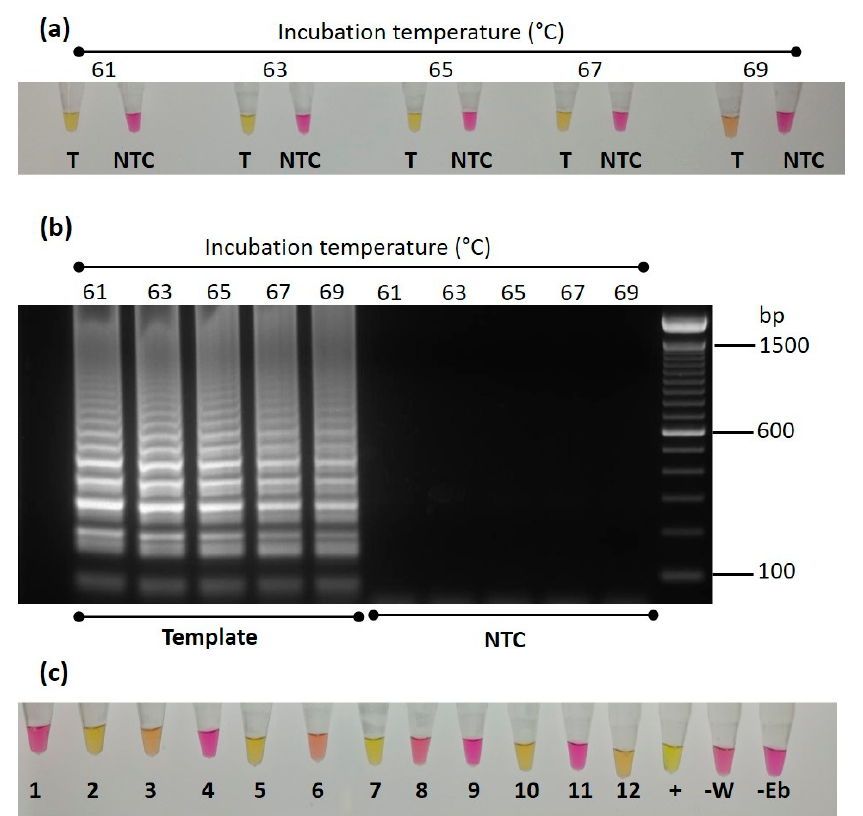
Figure 5. Optimization and testing of colorimetric Loop-mediated isothermal amplification (LAMP) for detection of cacao yellow vein-banding virus (CYVBV). ( a ) LAMP reaction containing 50 ng of DNA of symptomatic ICS 27 sample (T) or without DNA (NTC) were incubated at 61, 63, 65, 67 and 69 °C. After 30 min, samples were removed from the thermal cycler and cooled on ice to stop the reaction. Photograph shows the pink to yellow colour change in the reaction with template DNA. ( b ) The RT-LAMP reaction products were analysed on a 2% agarose gel. The typical band pattern of a successful LAMP reaction was visible in the reactions those contain ICS 27 DNA and showed colour change from pink to yellow. ( c ) Twelve LAMP reactions that contained 50 ng DNA of 12 samples GEBP 509/A-F (1), GU 144/C (2), GU 219/F (3), GU 263/V (4), GU 265/P (5), GU 341/H (6), IMC 85 (7), NA 70 (8), PA 175 [PER] (9), PA 156 [PER] (10), SHRS 09 (11), TRD 45 (12), along with a positive control ICS 27 (+) and two no template controls (-W -Eb), were incubated at 65 °C for 45 min. Photograph shows the pink to yellow colour change in positive samples.